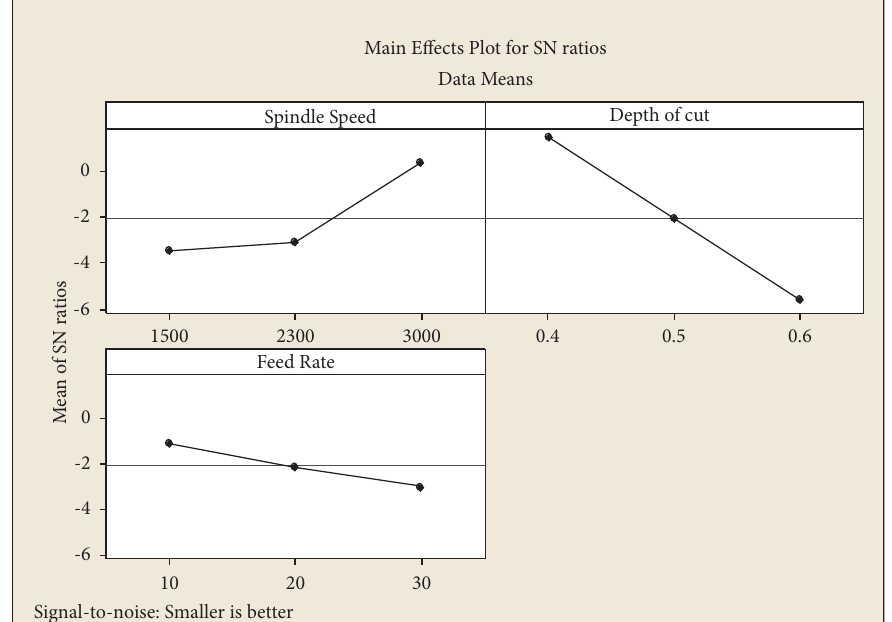
Figure 2: S/N ratio plot for R